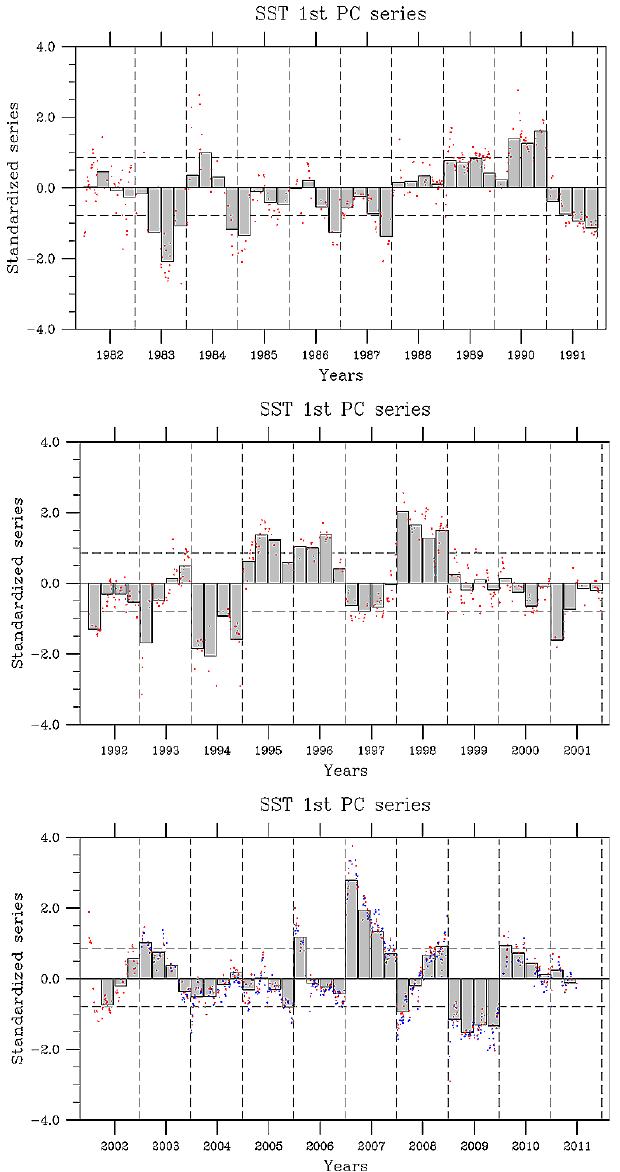
Fig. 7. The PC related to the EOF shown in Fig. 6. Vertical dashed lines indicate jumps from the end of February to the beginning of November of the same year. Red points are related to the PC de- duced from the 1981–2010 reconstructed SST PCA and the blue ones to the 2002–2010 reconstruction. Grey vertical bars give the mean monthly values of the red dot values, while the horizontal dashed lines the 20th and the 80th percentiles of the 3 decade daily time